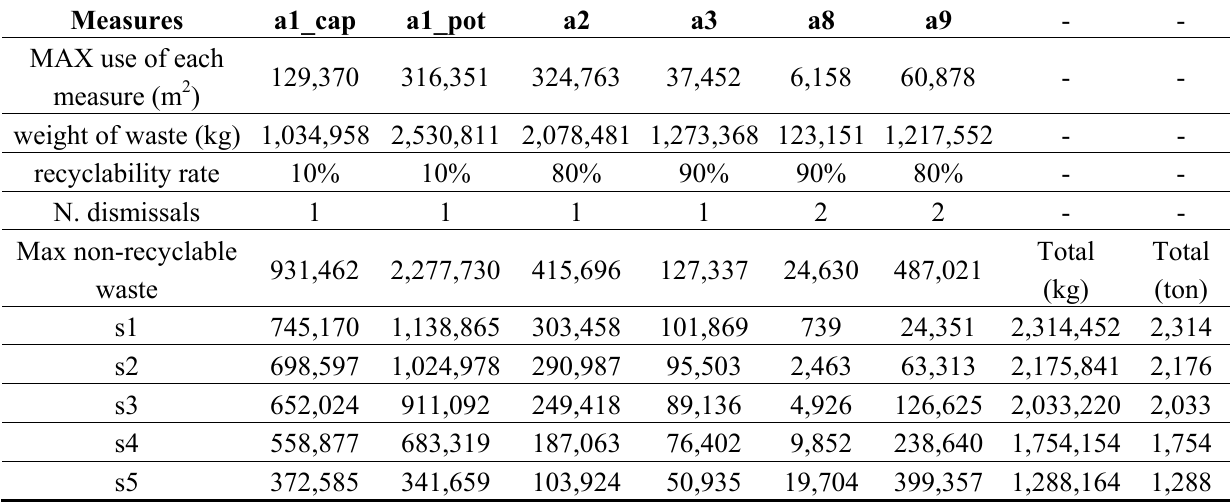
Table 10. Production of non-recyclable waste for each